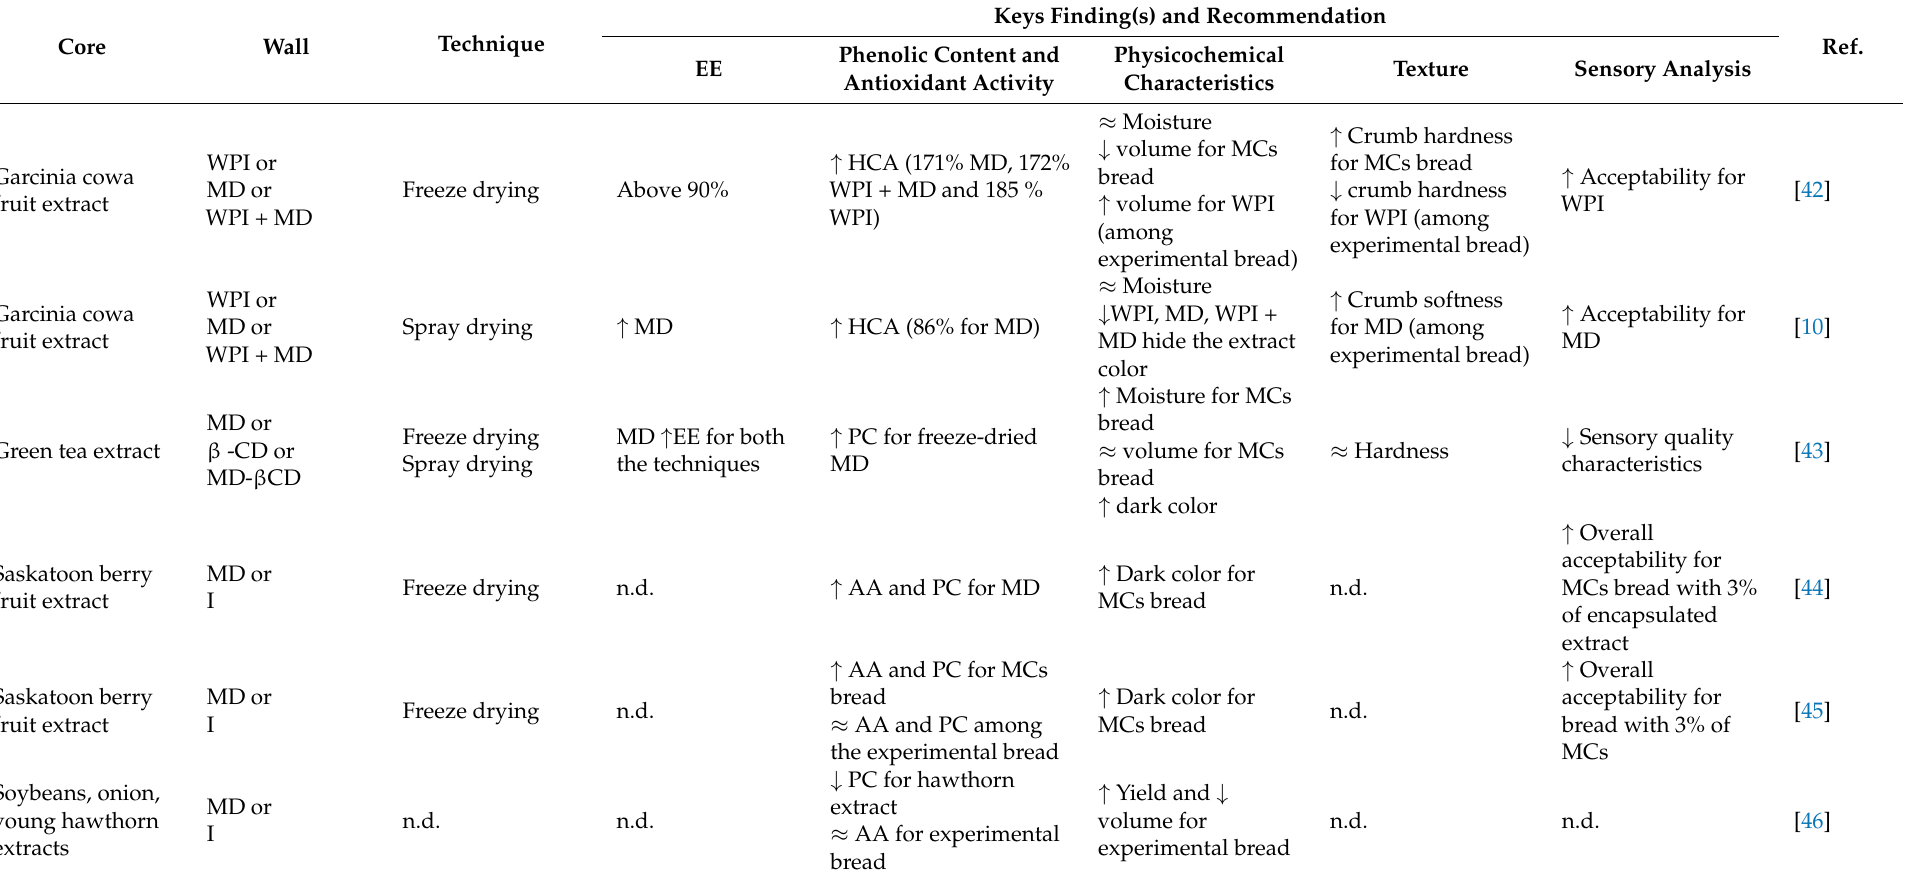
Table 4. Encapsulation of phenolic extracts for bread